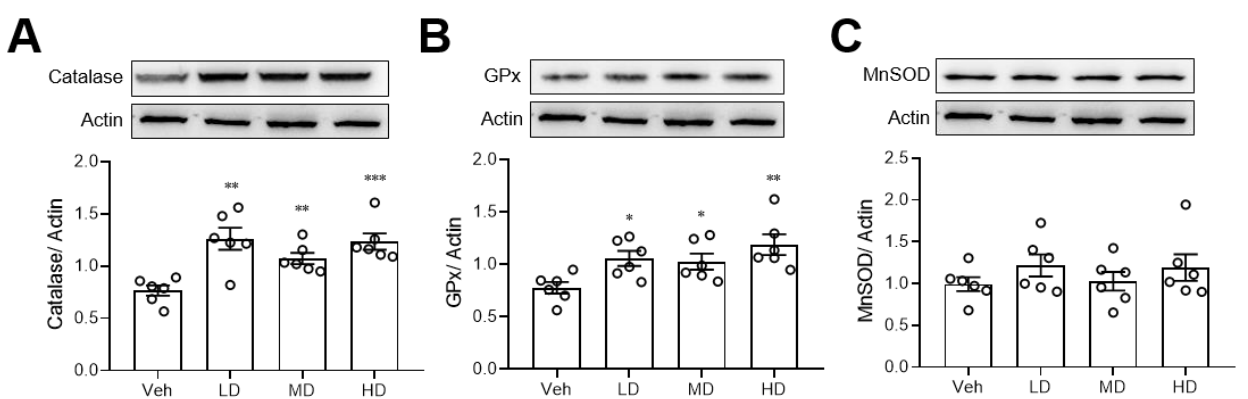
Figure 4. Coral hydrate increases anti-oxidative enzyme levels in ethanol-injected mice. Coral hydrate was administered to mice via oral gavage for 7 days before the intraperitoneal injection of ethanol. Two hours after the injection of ethanol, liver tissues of each group of the mice were removed for the determination of catalase ( A ), glutathione peroxidase (GPx) ( B ), and manganese superoxide dismutase (MnSOD) ( C ) protein levels were determined by Western blot. Low-dose group (LD), 105 mg/kg coral hydrate; Medium-dose group (MD), 210 mg/kg coral hydrate; High-dose group (HD), 420 mg/kg coral hydrate; vehicle group (Veh), 420 mg/ kg coral calcium dissolved in 3% carboxymethyl cellulose. N = 6 mice for each group; * p < 0.05; ** p < 0.01; *** p < 0.001 as compared with vehicle group.